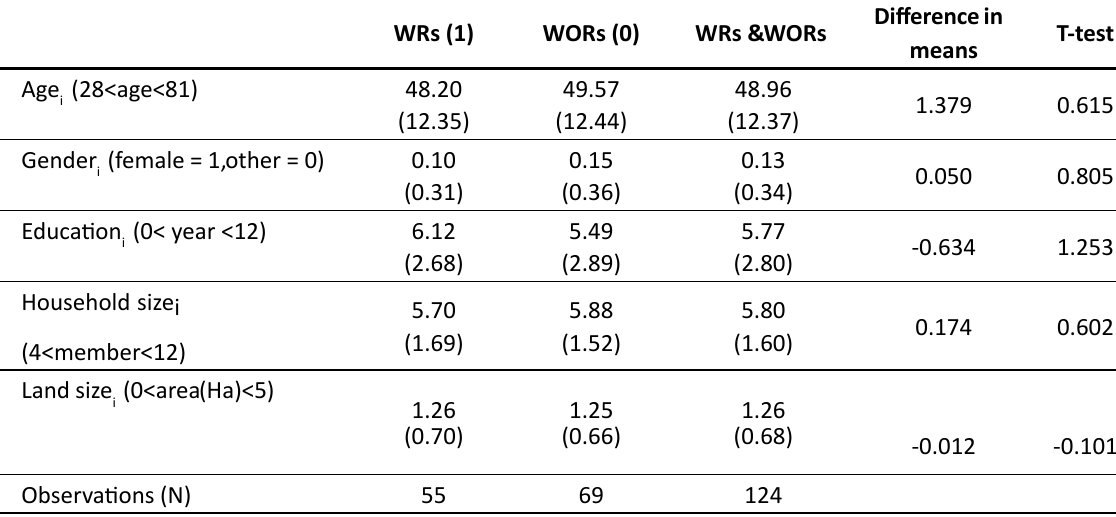
Table 1: Summary Statistics by Remittance Status-household Characteristics,